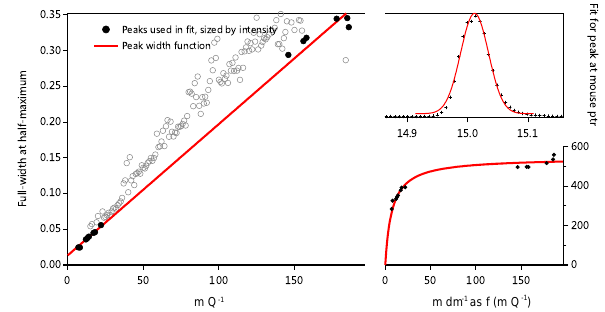
Figure 2. Ascertaining the peak width as a function of m/Q : the straight-line fit (peak width function, in red) is applied to the chosen data points (in black), giving the relationship for mass resolving power shown bottom-right. The principle behind this methodology is that isolated ions (in black) should exhibit narrower peak widths than those with adjacent ions (in